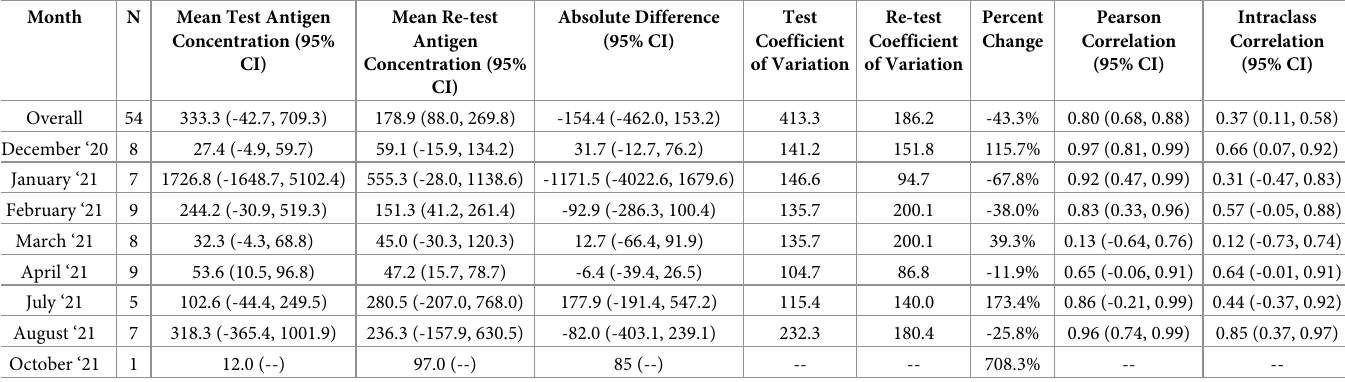
Table 2. Test and re-test antigen concentration differences by